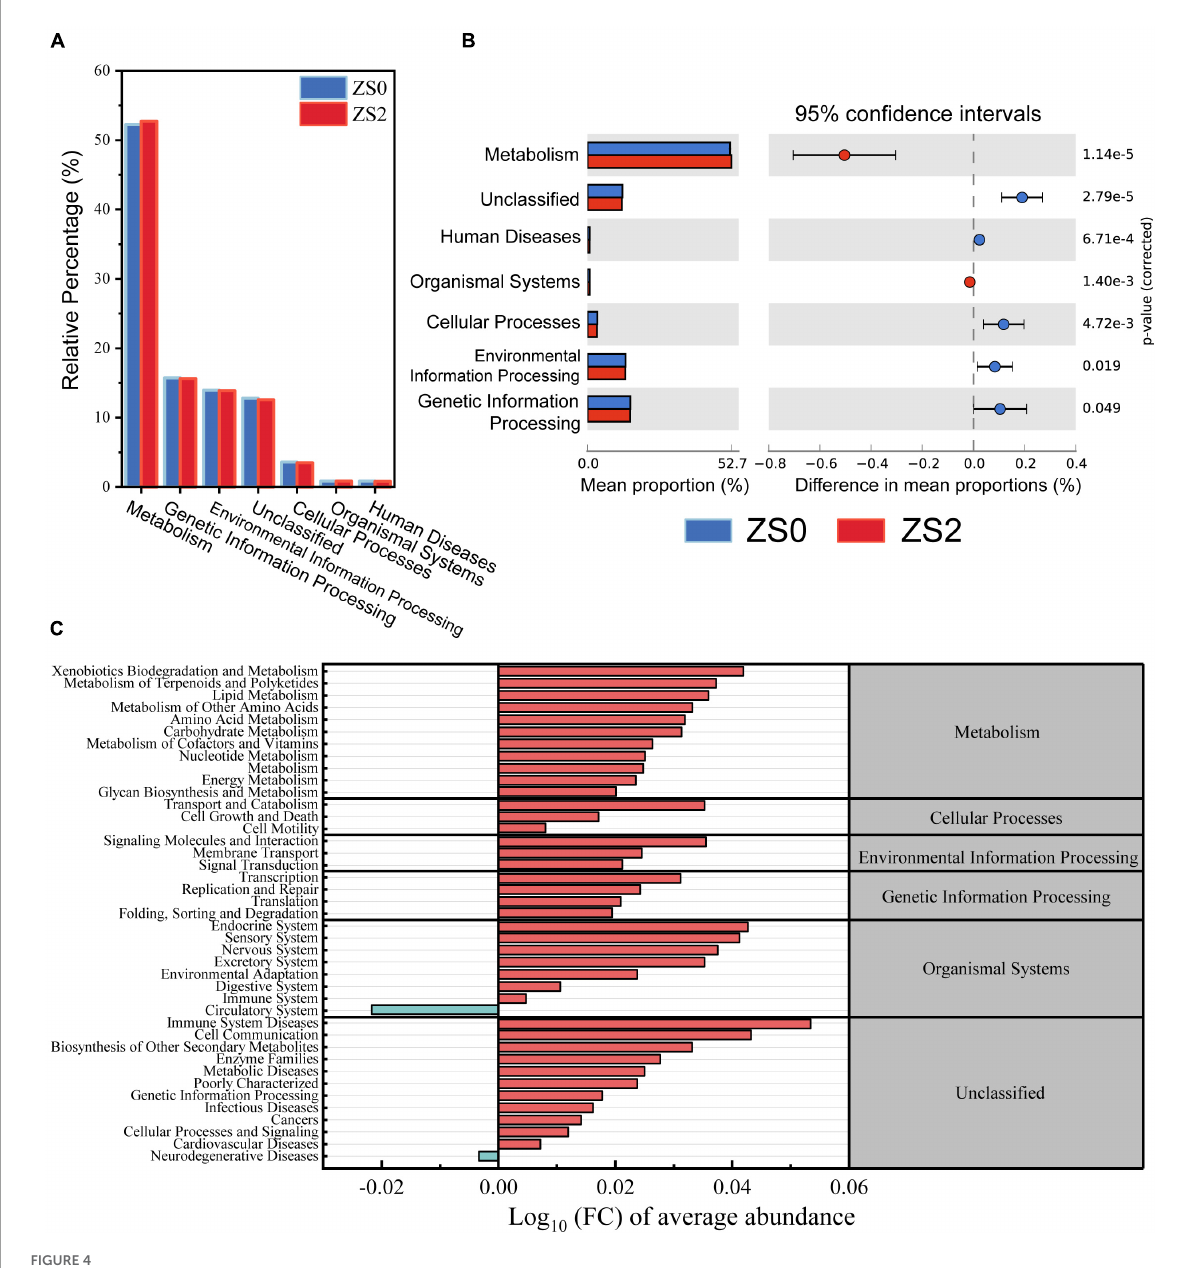
FIGURE4 (A) Relative percentage of predicted functional gene abundance (at L1 level by KEGG); (B) KEGG categories (L1 level) differing significantly between ZS0 and ZS2 based on Welch’s t -test, the mean proportion of majority pathway are overabundant within the rhizosphere soil of ZS0 compared to ZS2; (C) expression abundance multiples of bacterial function at the KEGG L2 level, most functions of ZS2 were upregulated compared to ZS0.